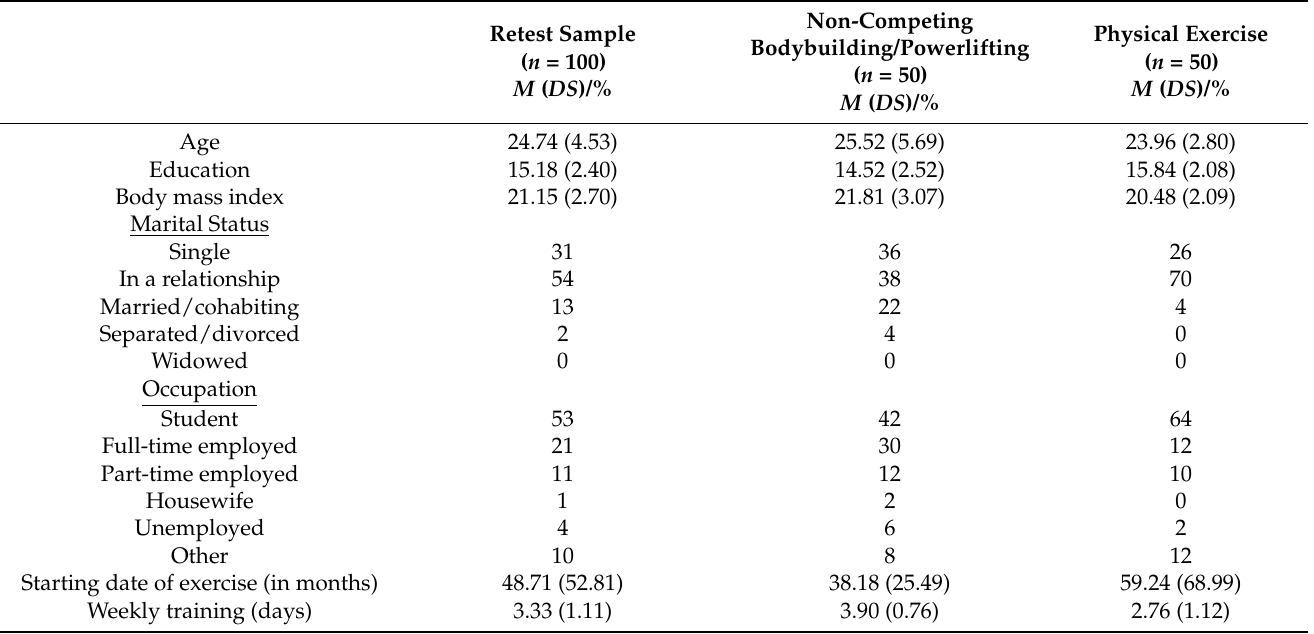
Table 2. Retest sample: